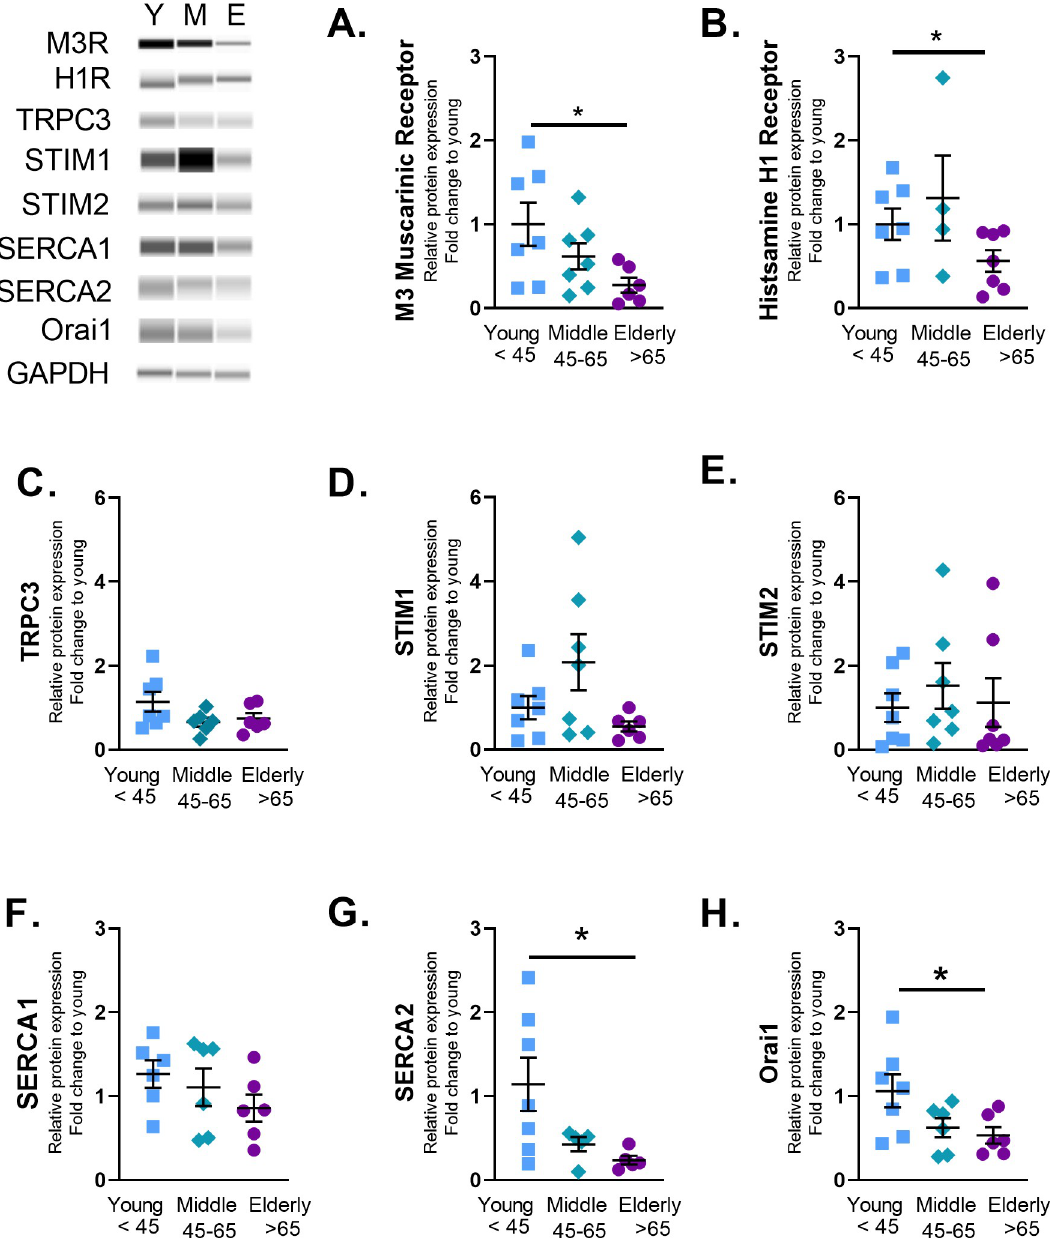
Fig 8. ASM Ca 2+ signaling receptors expression decreased with age. Total protein was isolated from young < 45, middle age 45–65, and elderly > 65 ASM. Wes analysis was used to measure changes in protein expression. Graphs represent relative expression vs GAPDH. ASM isolated from elderly patients ( > 65) had significantly decreased M 3 muscarinic receptor (A), histamine receptor (B), SERCA2 (G), and Orai1 (H) expression. Fold change was quantified using an average of young. Data shown as mean ± SEM from n = 4–7 patients. � indicates significant effect (p �